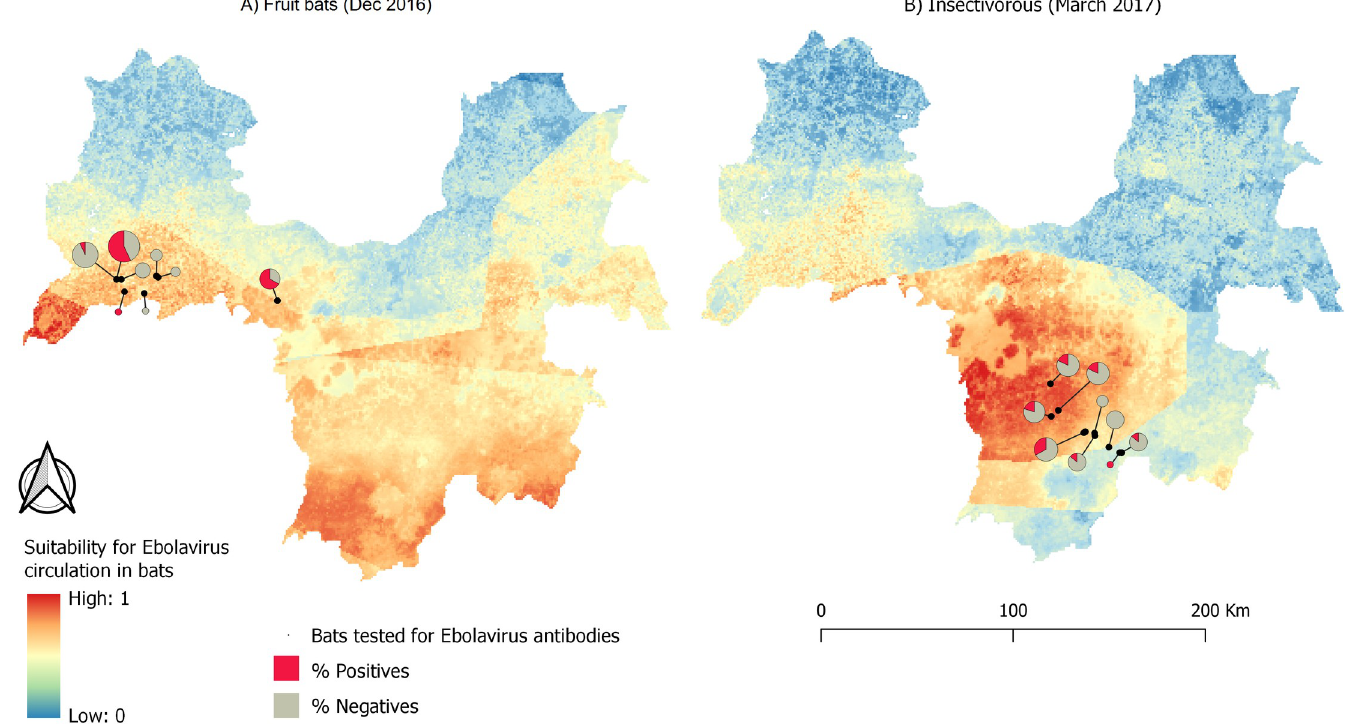
Fig 7. Suitability maps of Ebolavirus maintenance in fruit bats (A) and insectivorous bats (B) in Guine´e foresti è re. The size of the pie charts is scaled to sampling effort in each site (i.e. n = 1 for the smallest pie chart; n = 21 for the largest pie chart) (dataset available at https://doi:10.18167/DVN1/FZANMS).